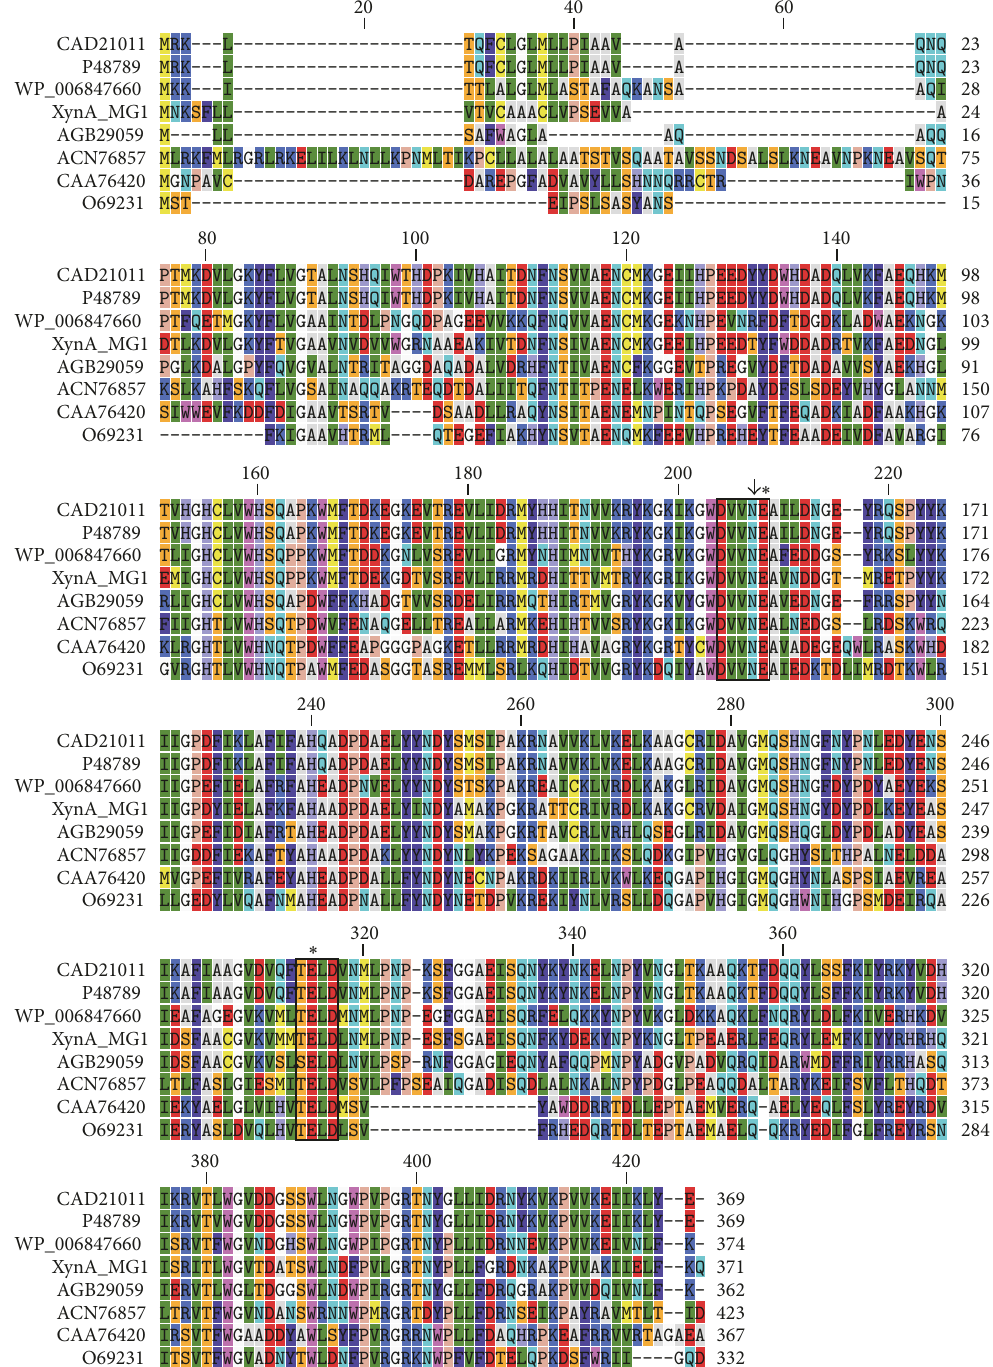
Figure 1: Amino acid sequence alignment of XynA MG 1 with closely related GH10 family beta-xylanases from Prevotella bryantii B14 (CAD21011), Prevotella ruminicola B(1)4 (P48789), Prevotella copri DSM 18205 (WP_006847660), Prevotella dentalis DSM 3688 (AGB29059), Paraglaciecola mesophila KMM 241 (ACN76857), Thermobacillus xylanilyticus D3 (CAA76420), and Paenibacillus barcinonensis BP-23 (O69231). The highly conserved motifs DVVNE and TEXD are shown in boxes, each containing an active site glutamate (marked with an asterisk) and an invariant asparagine residue (marked with an arrow) preceding the active site glutamate in the first